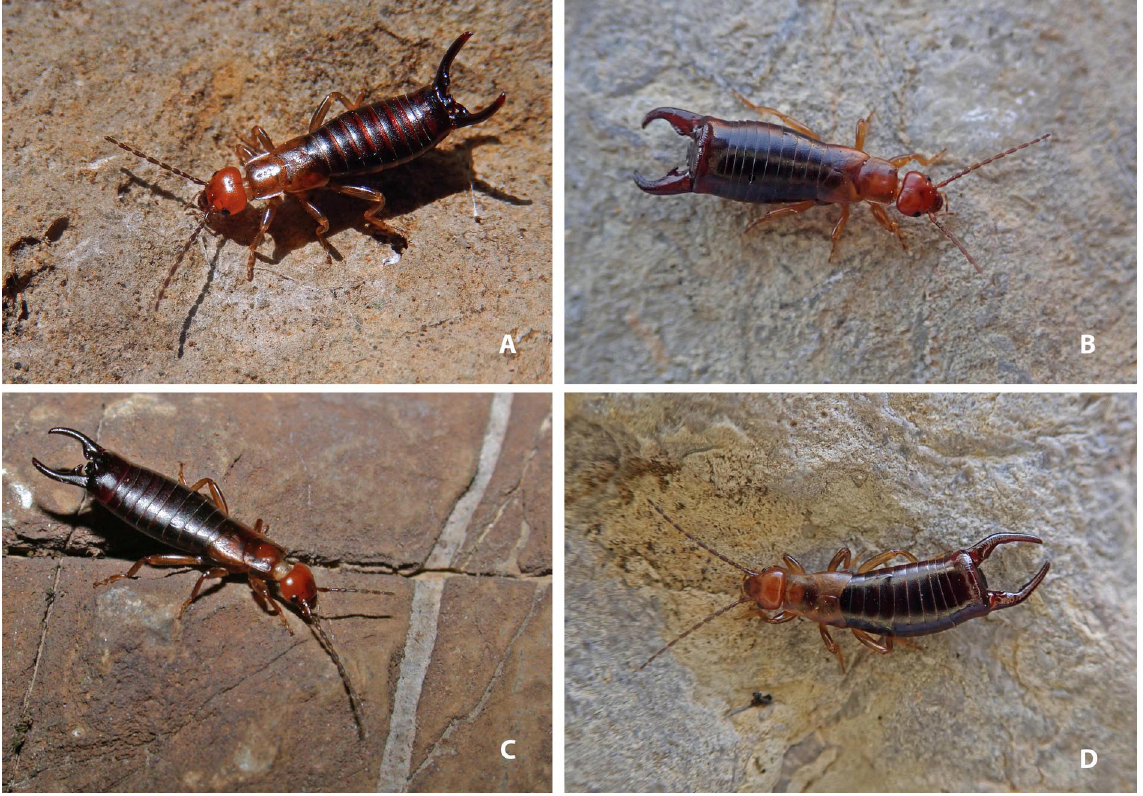
Fig. 4. Live specimens of Pseudochelidura cantabrica Cuesta-Segura, Jurado-Angulo & García-París sp. nov. and cerci variation. A . Male from Puerto de la Farrapona (León, Spain). B . Male from Puerto de Vegarada (León, Spain) (ADC-S col. Derm_0006). C . Male from Puerto de Ventana (León, Spain). D . Male from Puerto de Áliva (Cantabria, Spain) (ADC-S col. Derm_0008). Photographs ex situ by ADC-S (A–B, D) and MG-P